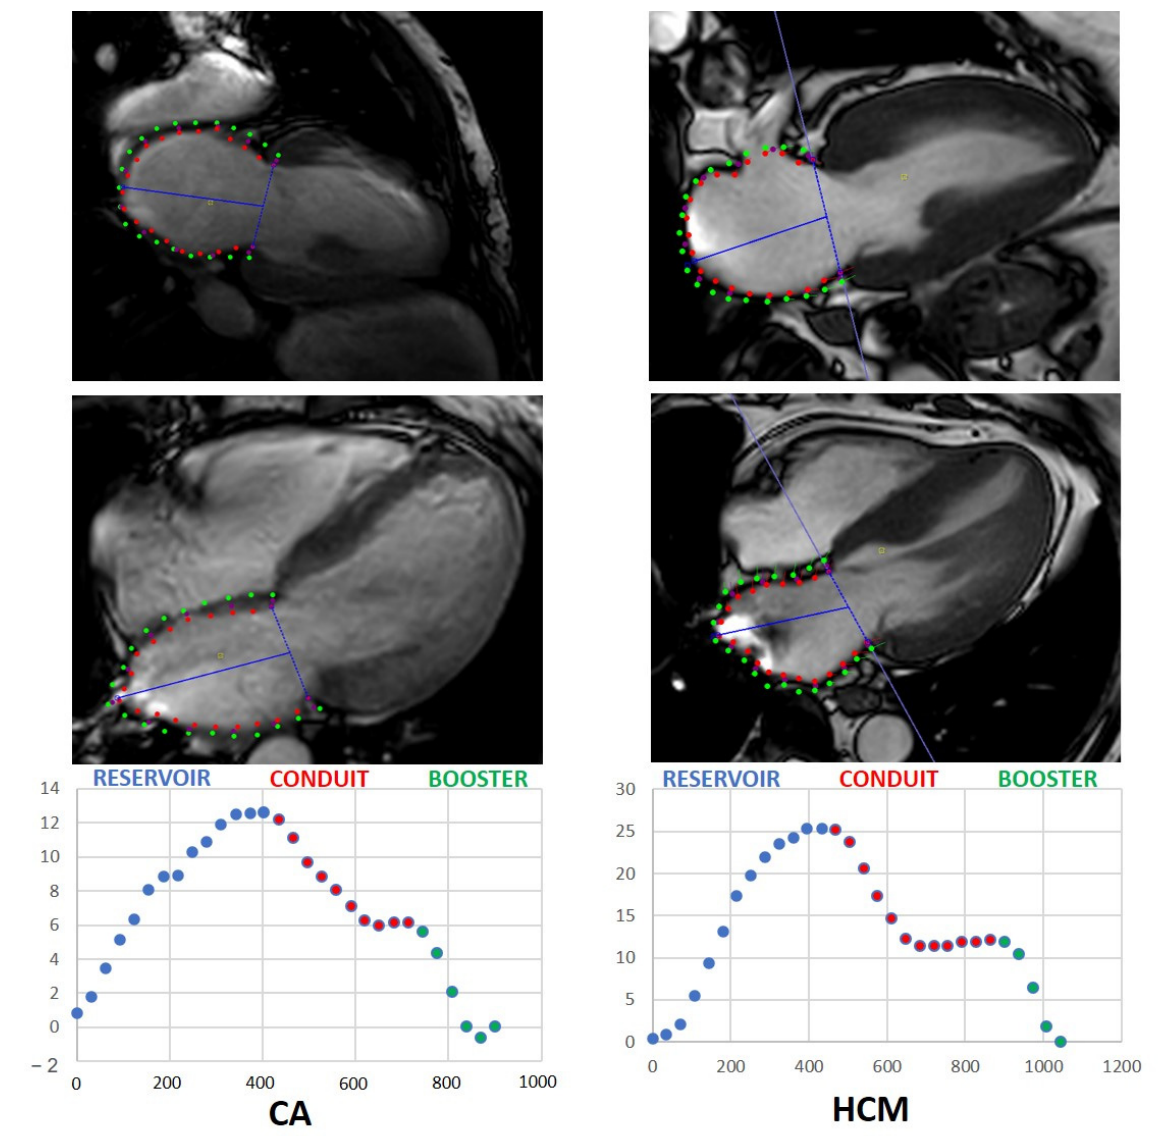
Figure 1. Left atrial strain measurements in patients with CA and HCM. ( Upper row ): longitudinal two-chamber view; ( Lower row ): left atrial longitudinal strain-to-time curve. Red dots in MRI images represent endocardial contours; green dots represent epicardial contours. CA: cardiac amyloidosis; HCM: hypertrophic cardiomyopathy.